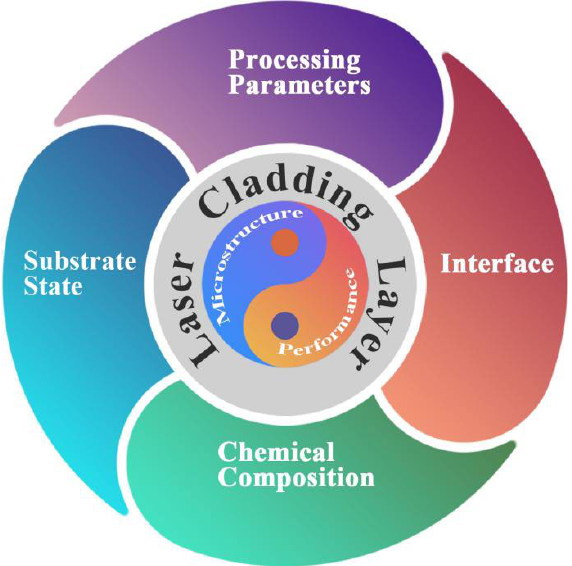
Figure 15. The schematic diagram of the main influencing factors on the laser cladding coating.